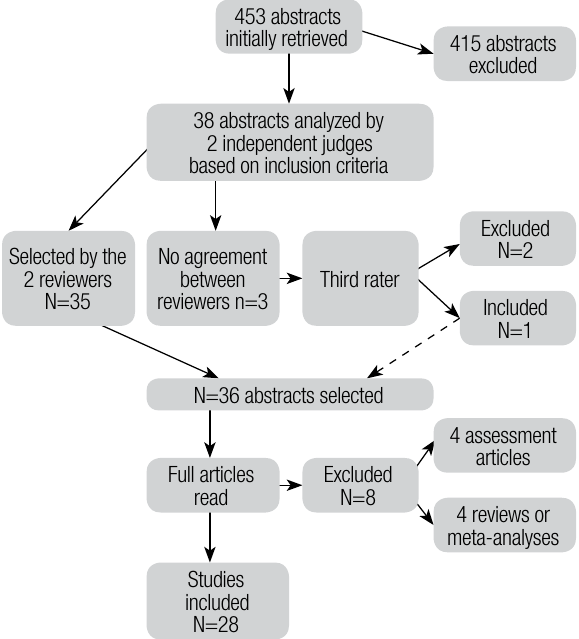
Figure 1. Flow diagram of the article selection